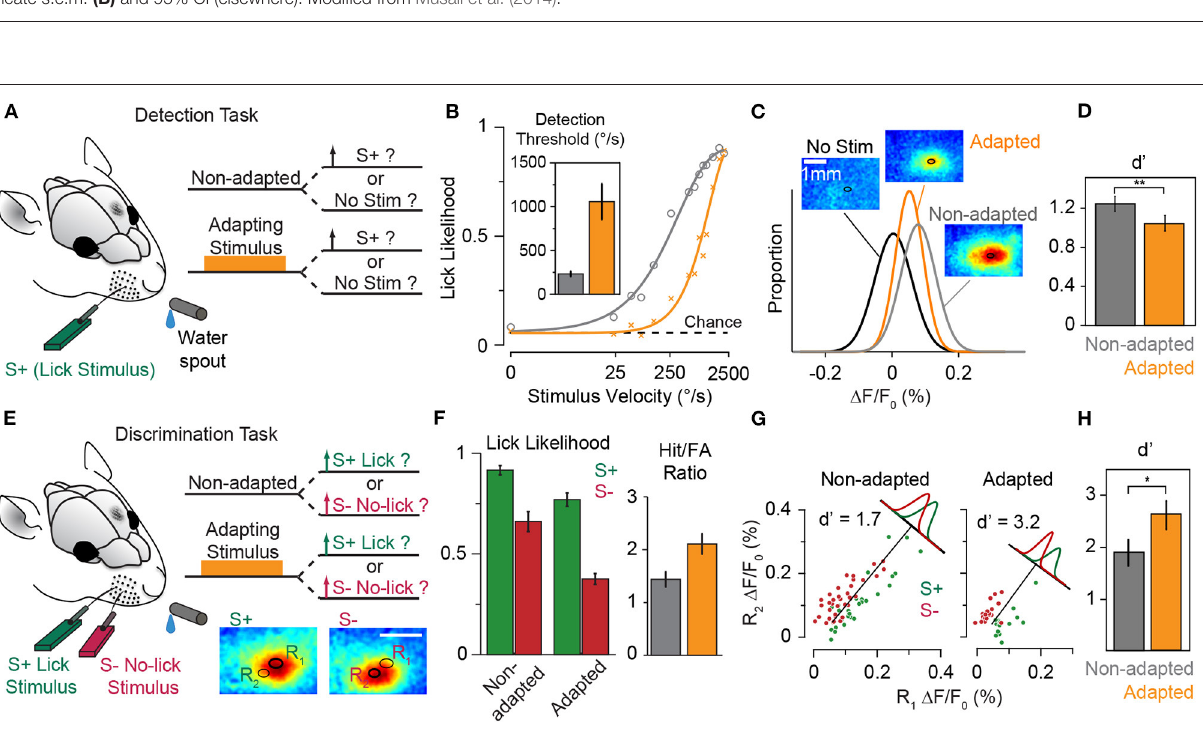
FIGURE 9 | the first and third quartiles, the inner line is the median. Box whiskers represent minimum and maximum values. (J) Deviant stimulus detection performance as a function of number of deviant stimuli, was higher for whisker stimuli than photo-stimulation. Deviant detection task: two base sequences of either whisker or photo stimuli (at M 50 amplitude, 20-Hz frequency and duration of 2 s) presented bilaterally. The target sequence (left or right) contained 1, 4, or 10 deviant pulses of M